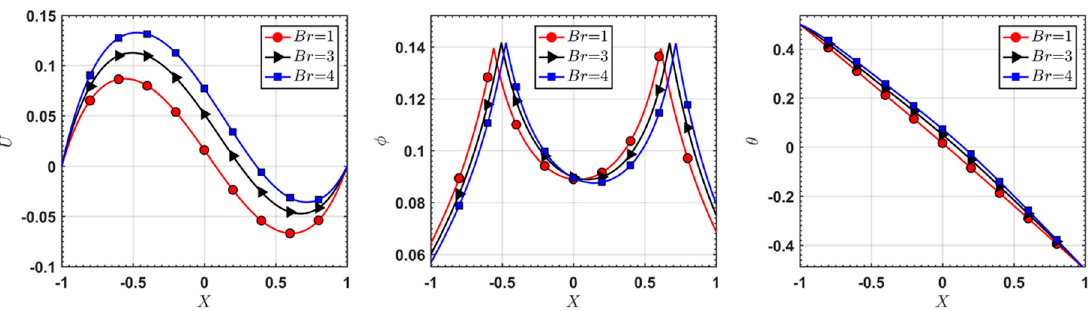
Figure 5. Effect of Brinkman number ( 𝐵𝑟 ) on the velocity, concentration and temperature profiles, when 𝛤 𝑐 = 2.5 , 𝛤 𝜇 = 0.1 , 𝐿𝑒 = 10 , 𝑛 = −0.5 , 𝛿 = 1 , 𝑅𝑎 = 3 and 𝜙